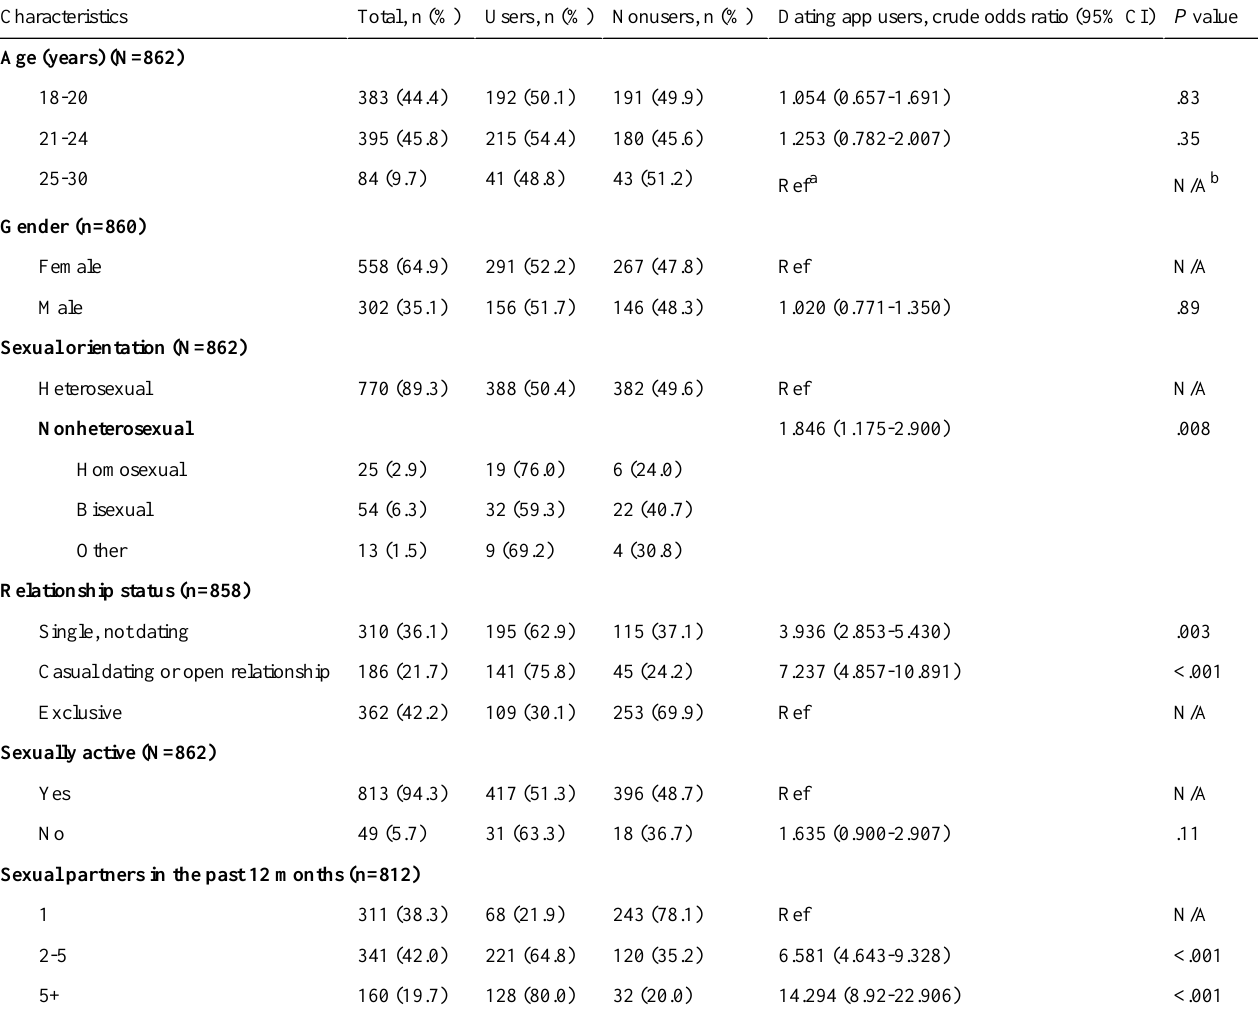
Table 1. Logistic regression of geosocial networking dating app users and demographics